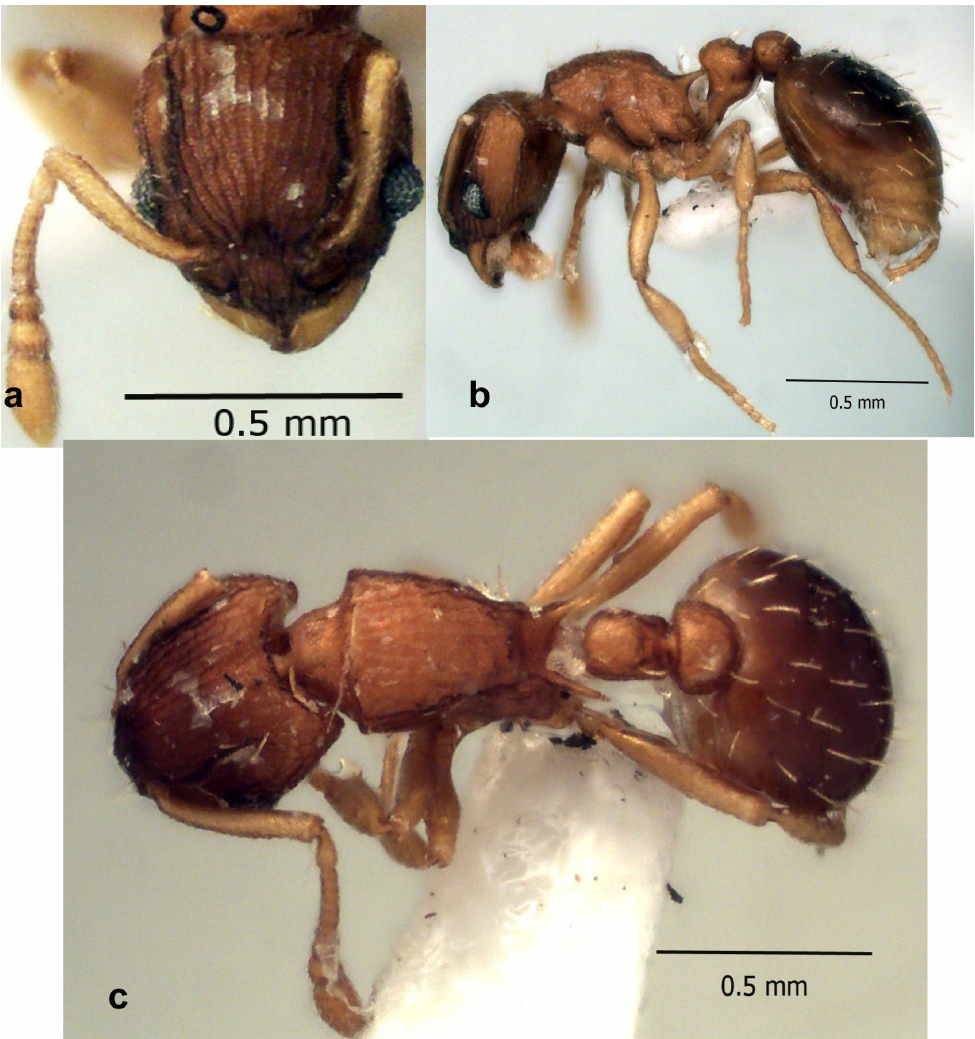
Figs 6a-c . Worker of Wasmannia sulcaticeps . 6a, head in full-face view; 6b, profile; and 6c; dorsal